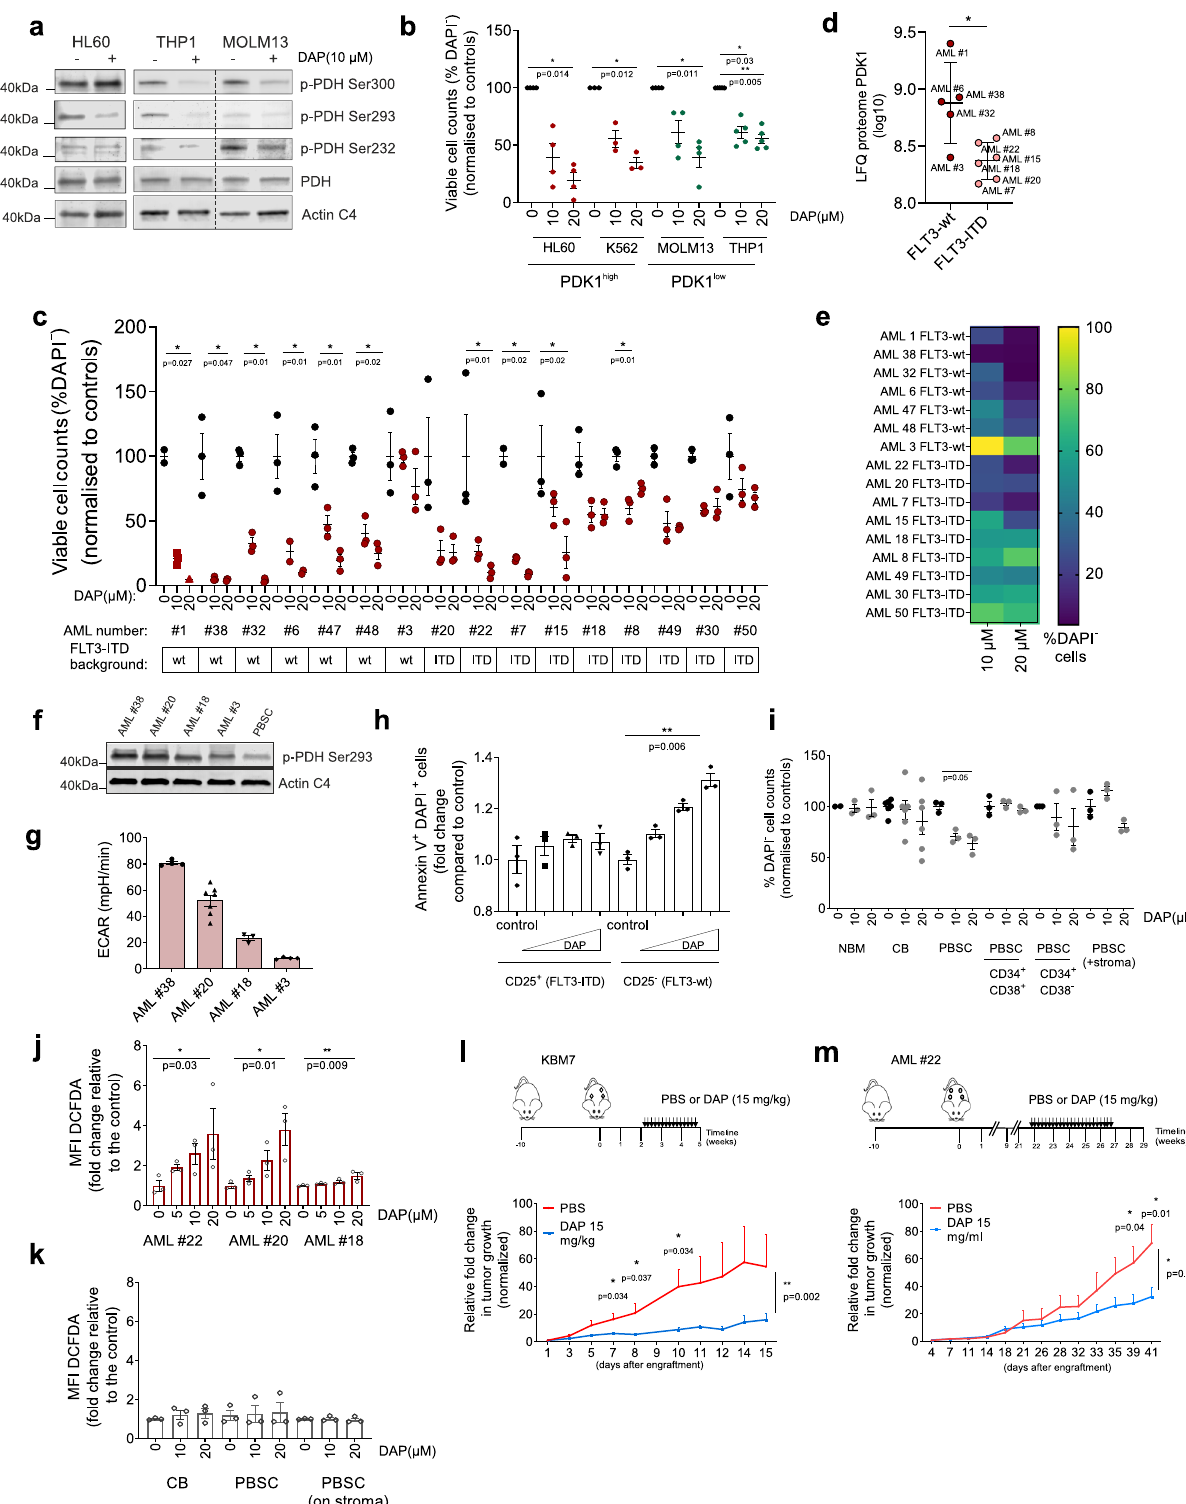
fi nd that PDK1 was most consistently upregulated across multiple independent proteome and transcriptome datasets, compared to normal CD34 + cells. The upregulation of PDK1 was not uni- formly detected in all patients, but in particular in those that were enriched for LSC-signatures, coinciding with the lowest oxygen consumption rates. These AMLs were also the most sensitive